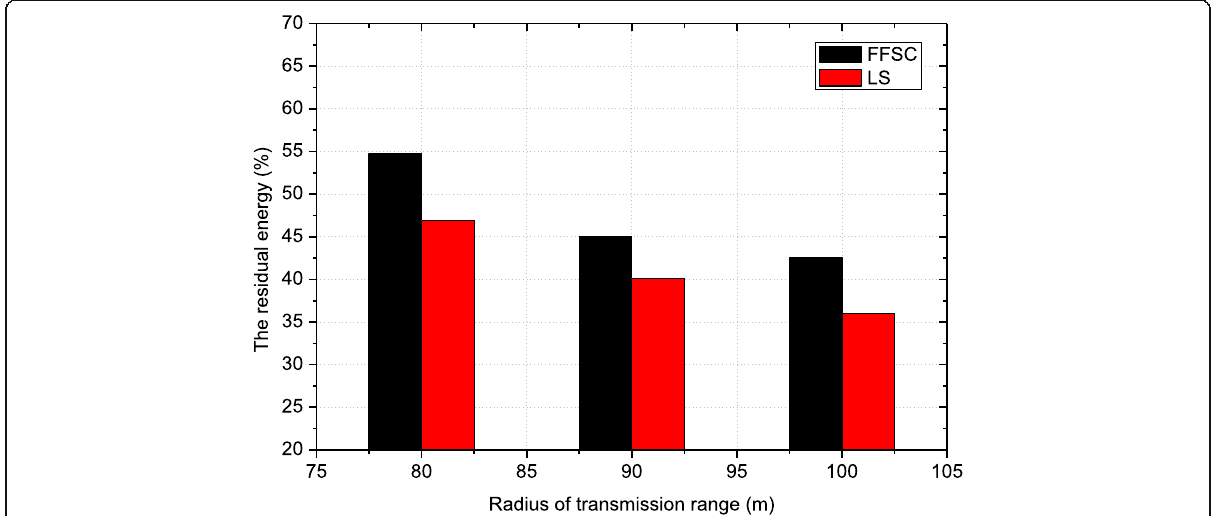
Fig. 16 The residual energy under different transmission range